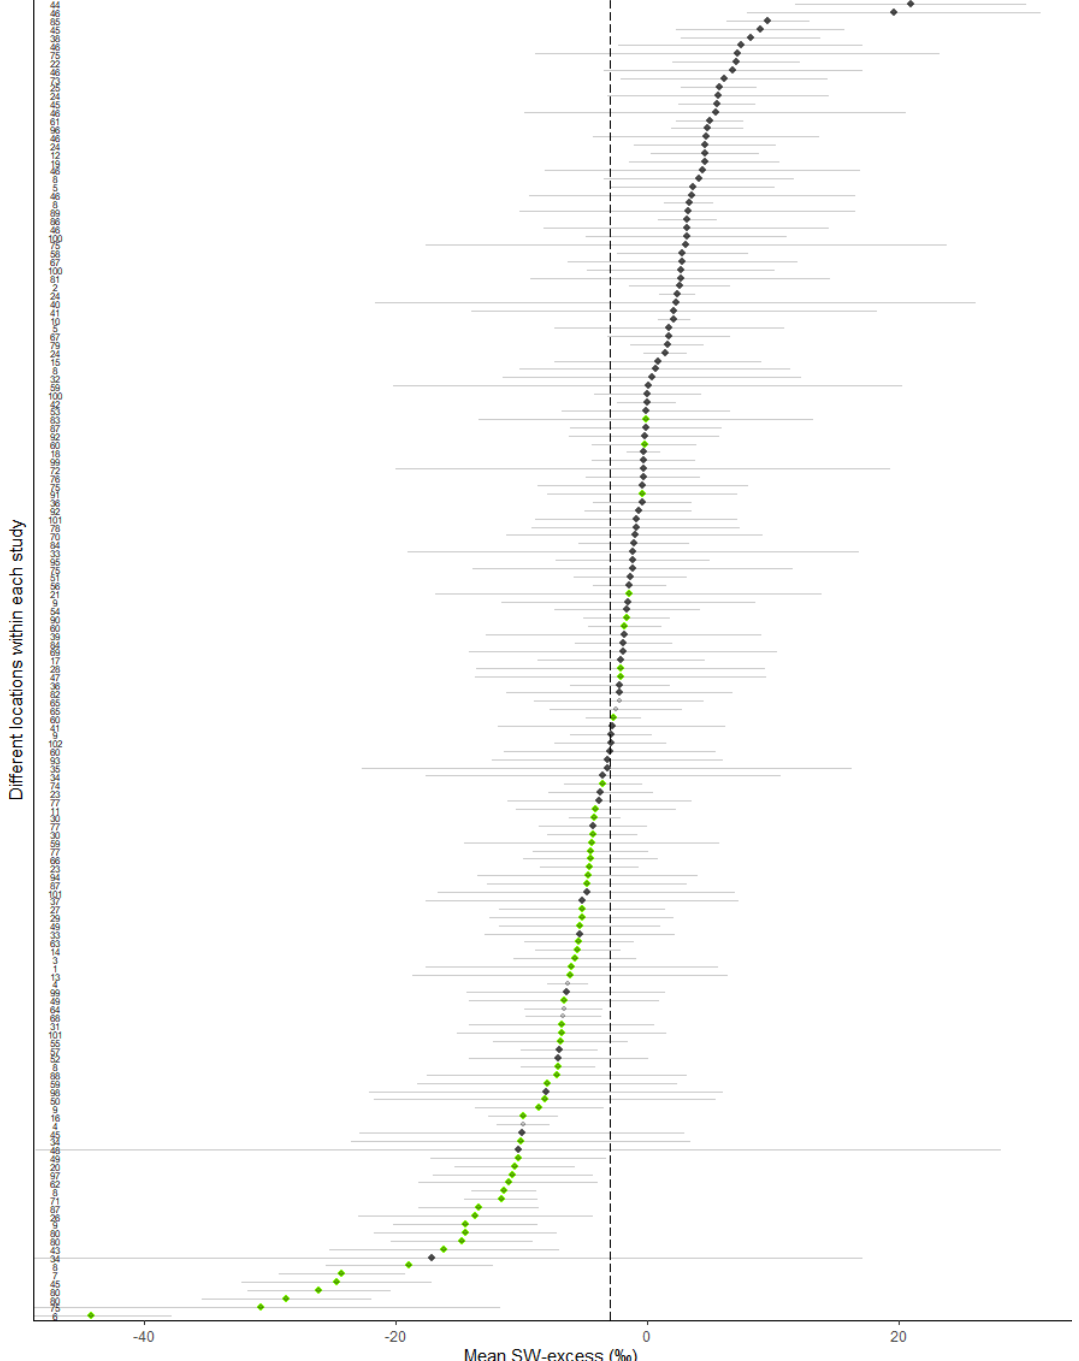
Figure 2. Mean ( ± SE, n = number of records per study site) soil water excess (SW-excess) for each study site. The dotted line is the overall mean estimate of SW-excess ( − 3.02‰) according to the null linear mixed model. Each dot corresponds to a study site (see ID numbers on the left and in Table 1 for the corresponding references). Filled green dots depict study sites where both the line conditioned excess (LC- excess) and SW-excess (plus their corresponding SE) were negative for at least one campaign and dark grey dots depict study sites where LC-excess and/or SW-excess were not different from zero for all campaigns. Colourless dots depict glasshouse studies.